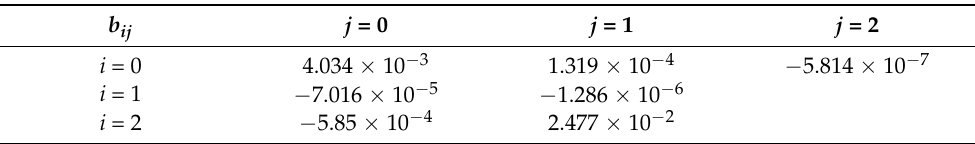
Table 2. Fitting correction coefficients of temperature–pressure and solubility correction factors in Equation (13).